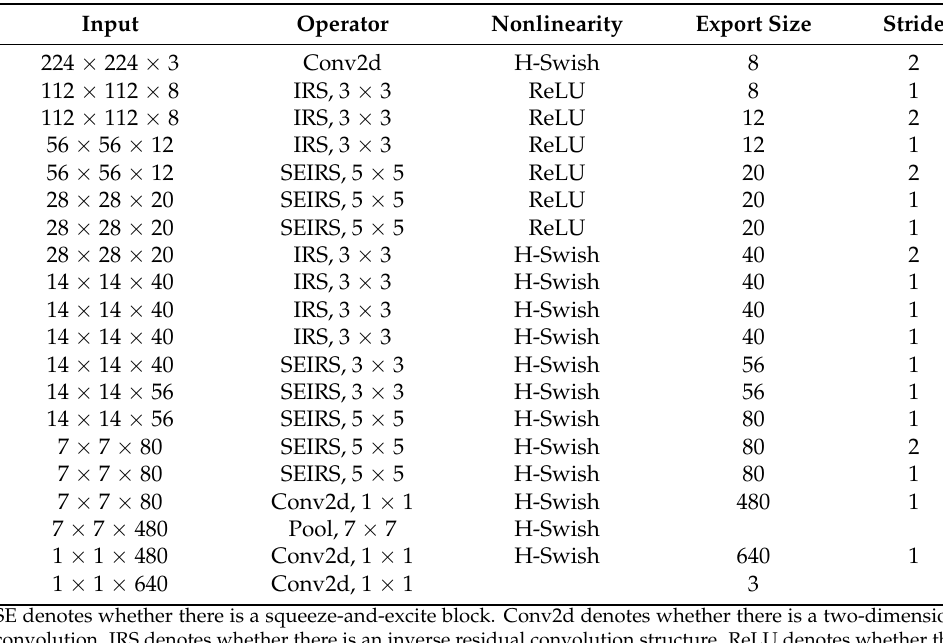
Table 4. The structure of MobileNetV3_egg.